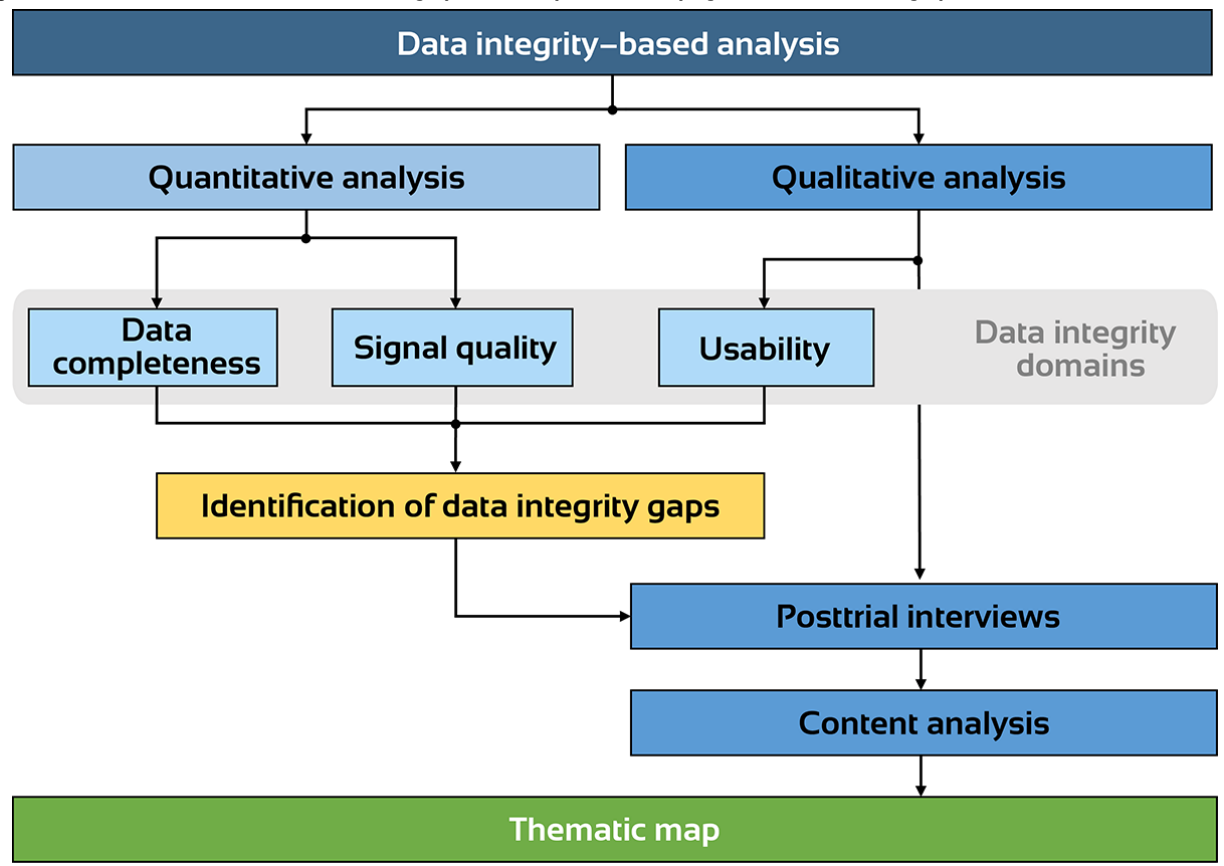
Figure 1. The flowchart demonstrates the data integrity–based analysis for identifying the source of data integrity